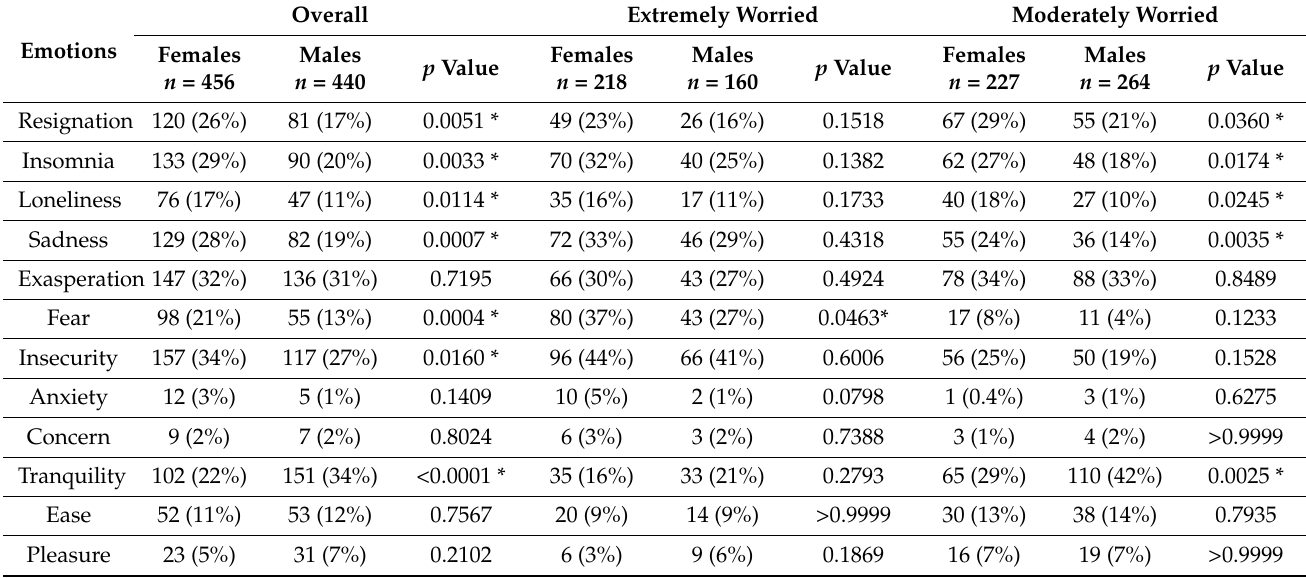
Table 2. Gender differences in COVID-19 perception among participants based on grade of